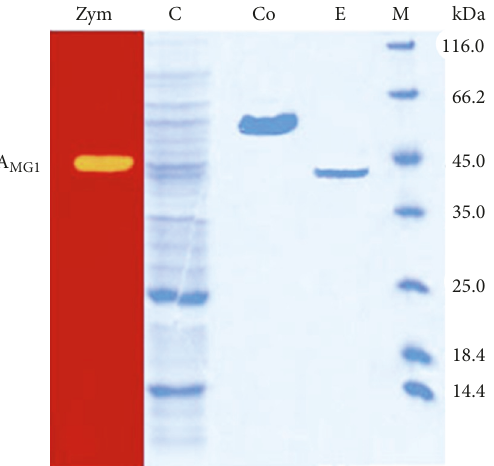
Figure 4: Purification steps of XynA MG 1 and zymogram analysis. Proteins were separated with 12% gel SDS-PAGE. Lane (Zym) zymogram, lane (C): total soluble cell lysate from E. coli host expressing XynA MG 1 , lane (Co): Trx-His-XynA MG 1 fusion protein purified by TALON cobalt resin, lane (E): purified XynA MG 1 after digestion with enterokinase, and lane (M): protein molecular weight markers.